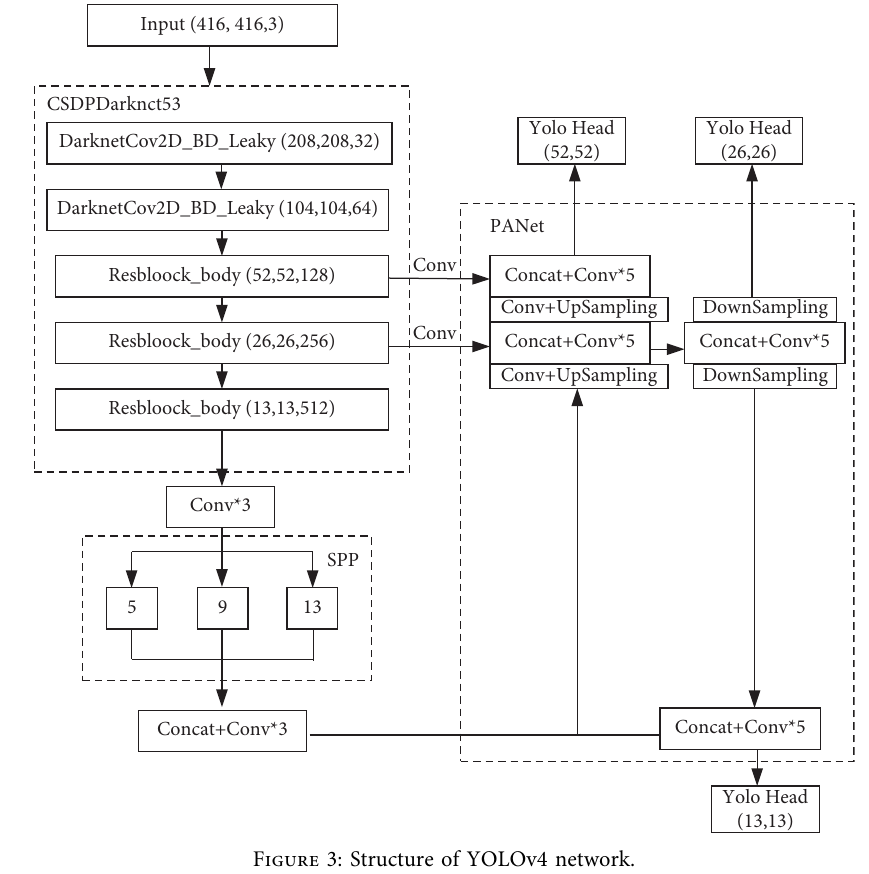
Figure 3: Structure of YOLOv4